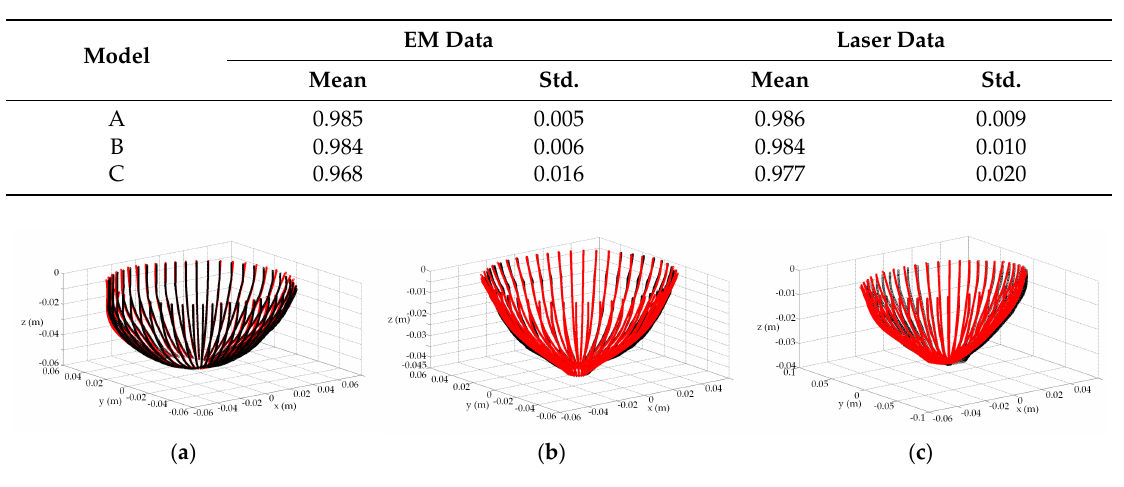
Figure 12. Comparison between the goodness of fit of profile as the azimuth angle varies between profile estimated with electromagnetic (black) and laser (blue) surface samples for models A ( a ), B ( b ), and C ( c ). Table 5. Mean and standard deviation of profile GOF over 120 profiles.